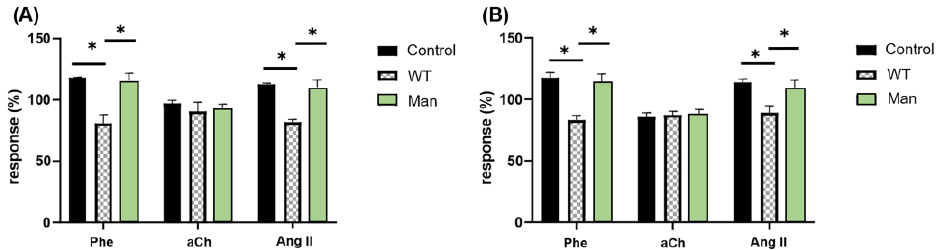
Figure 3. C. albicans interacts with coronary endothelium and inhibits the effects of agonist-induced GPCRs, and this inhibition is reversed by mannose. ( A ) Vascular and ( B ) inotropic effects of Phe, aCh and Ang II agonists were determined at the beginning of the experiment (Control), as well as after interaction with C. albicans WT yeasts (WT) and after washout with mannose (Man). Bars (mean ± SD) show the result of at least three independent experiments (* p < 0.05).